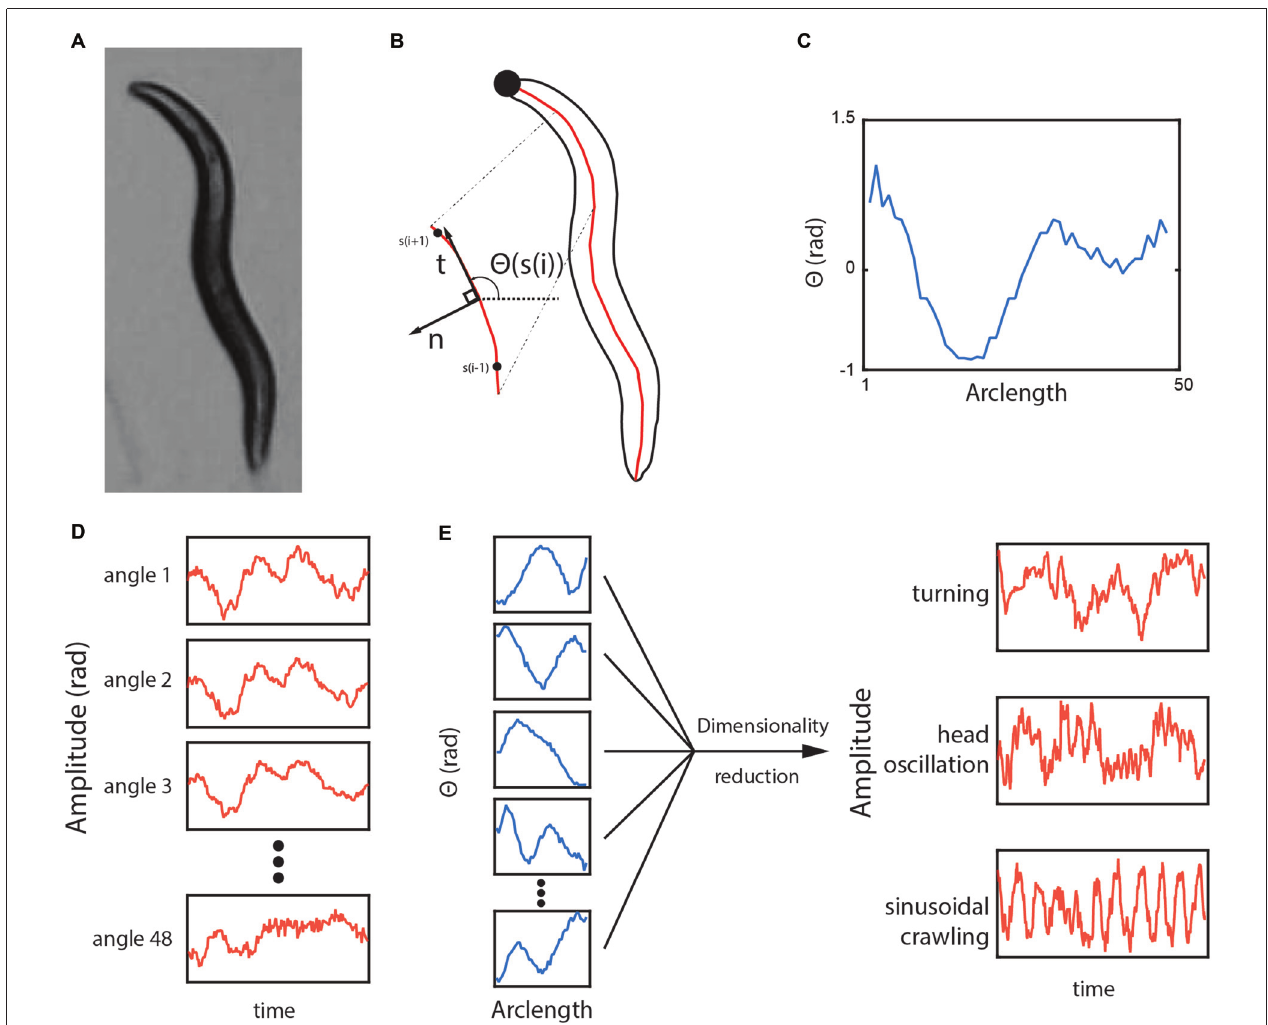
FIGURE 1 | (A) A typical frame of a worm under the tracking microscope. (B,C) The outline and the curve through the center of the worm. The angle in radians between neighboring points along the centerline is plotted from the tip of the head ( s = 1) to the end of the tail ( s = 48). (D) As the worm moves, the value of each angle changes, but each subsequent angle provides little additional information because they are highly correlated with each other. (E) Dimensionality reduction methods can reveal more biologically meaningful time-series